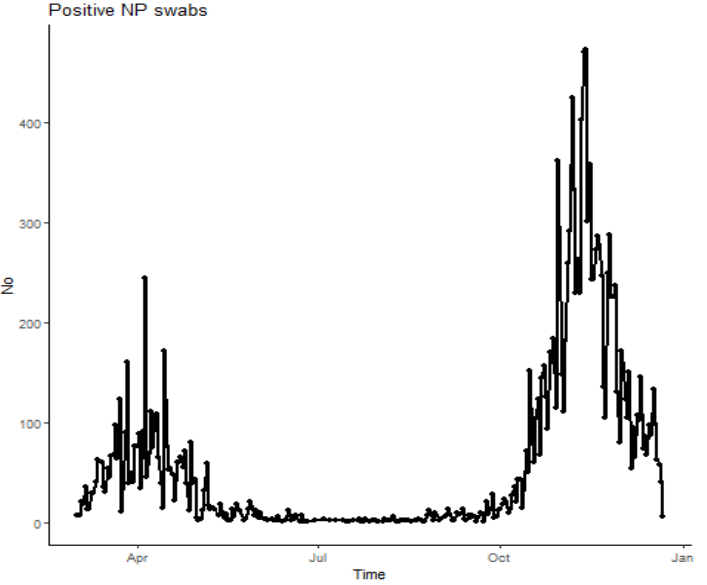
Figure 2. Time series of subjects with at least one positive NP swab.